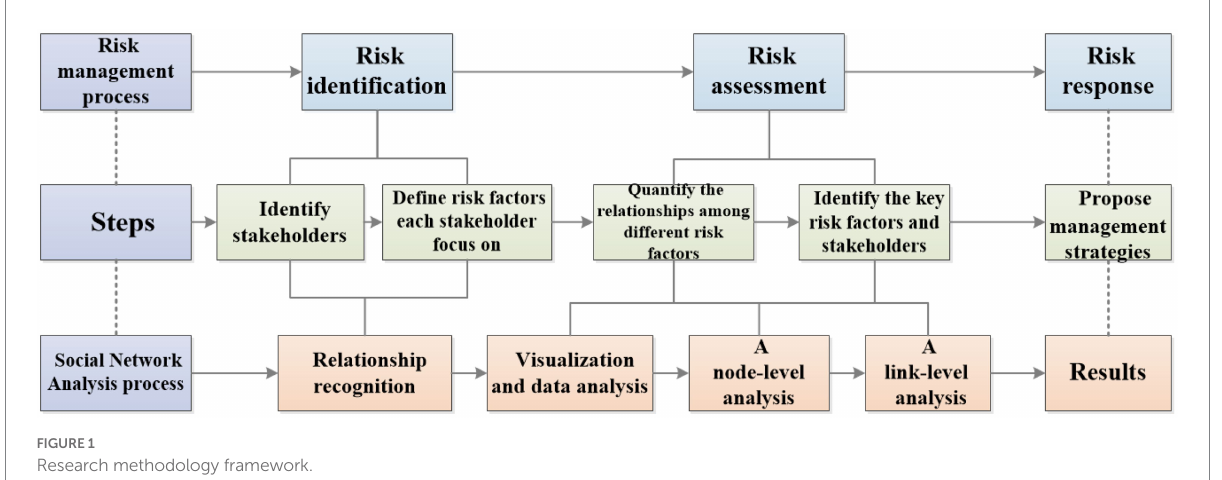
FIGURE 1 Research methodology